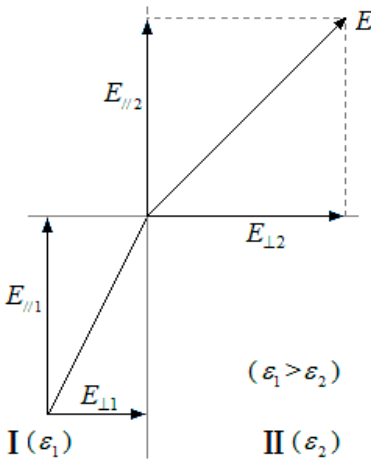
Figure 2. The differences in dielectric capacities in the microscopic structure lead to the deflection of the electric field in the polymer matrix.